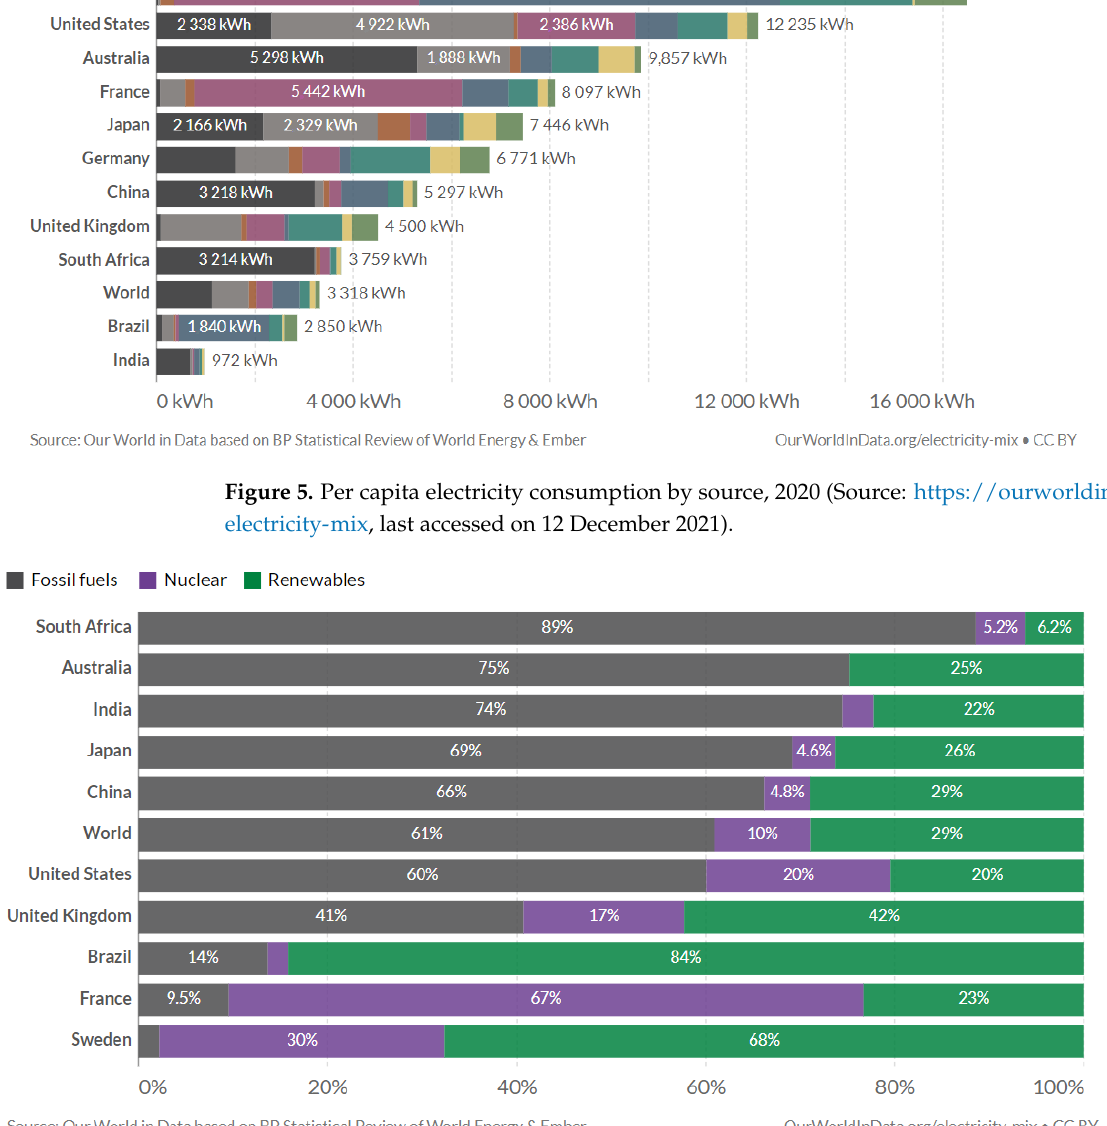
Table 1. Spearman correlation between annual temperature, energy price and some financial instru- ments in Germany, UK and France.